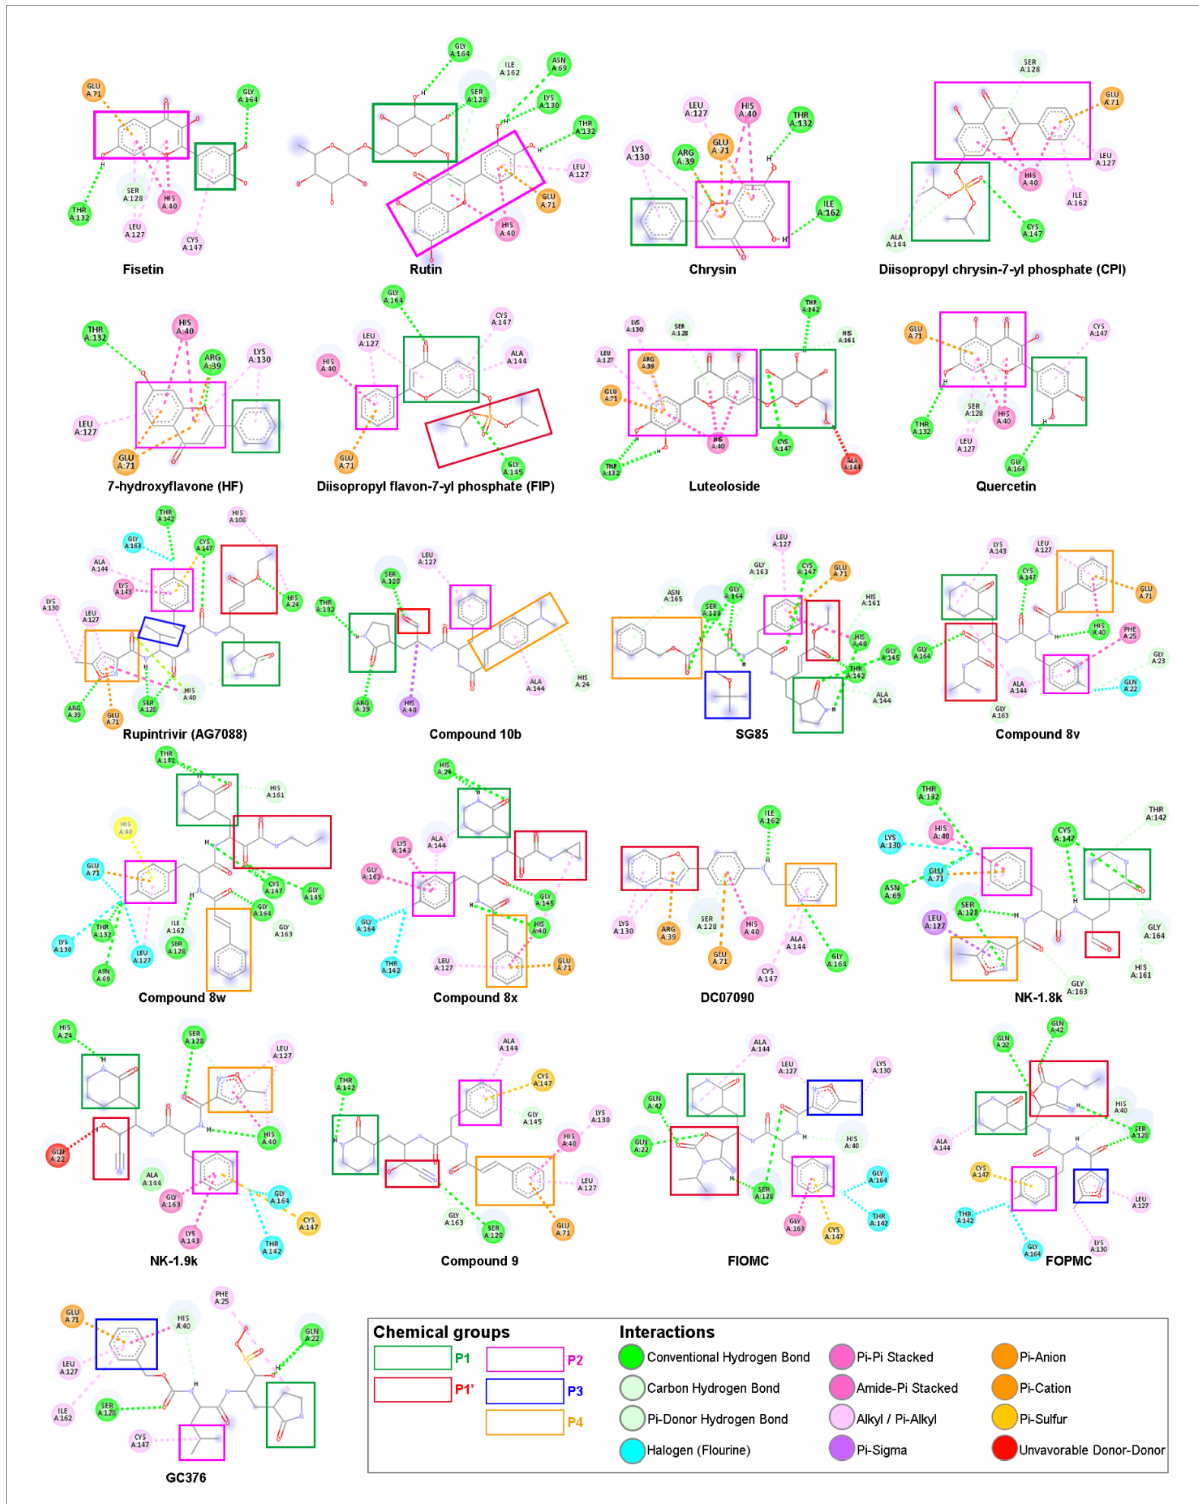
FIGURE4 Chemical structures of 21 ligands with five interacted chemical groups—showed in colored rectangles—and their interacted amino acids—showed in colored circles—at cluster 1 with 5C1U. The figure was modified from the illustration of BIOVIA Discovery Studio Visualizer v21.1.0.20298 (BIOVIA,